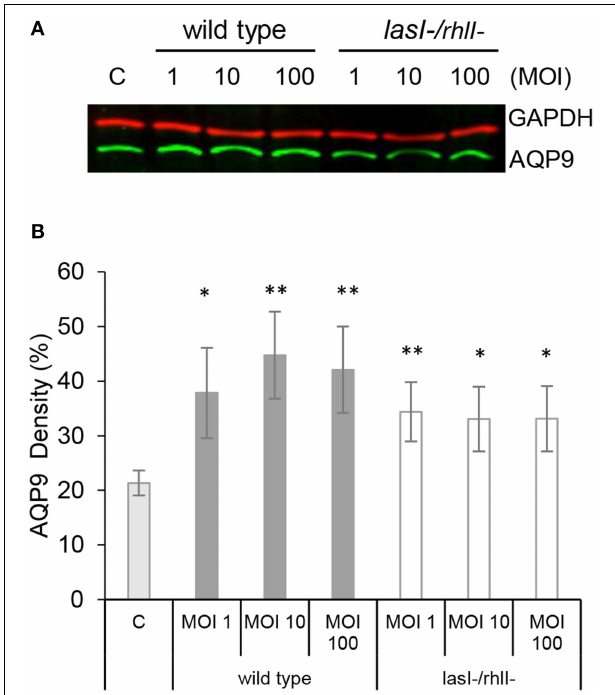
FIGURE 3 | AQP9 protein levels are increased in macrophages infected with P. aeruginosa . (A) Macrophages were either non-infected (C) or infected with wild type P. aeruginosa or lasI-/rhlI- mutant at MOI 1, 10, and 100 for 1h. Total cellular protein extracts were analyzed with Western blot for AQP9, 31kDa (lower, green bands) and GAPDH, 36kDa as a loading control (upper, red bands). The blots are from one representative of four independent experiments. (B) Densitometric analysis. Values are mean ± SE percentage of AQP9 density relative to the loading GAPDH control from four independent experiment performed at separate days from four different donors. Significant differences are indicated when * P < 0 . 05 and ** P < 0 . 01 , as analyzed by Student’s t